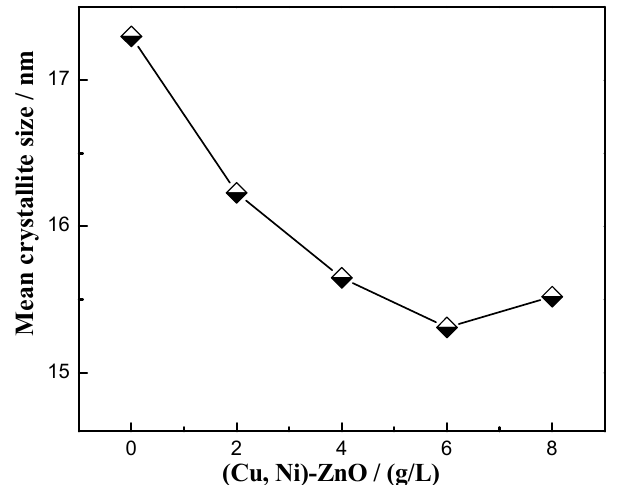
Figure 2. The mean crystallite size of Cu-Ni-ZnO nanocomposite coatings with different (Cu, Ni)-ZnO additions.